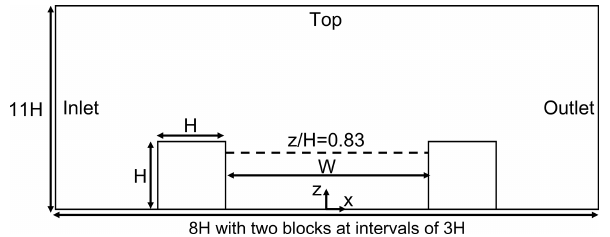
Figure B1. Simulation domain for velocity validation.